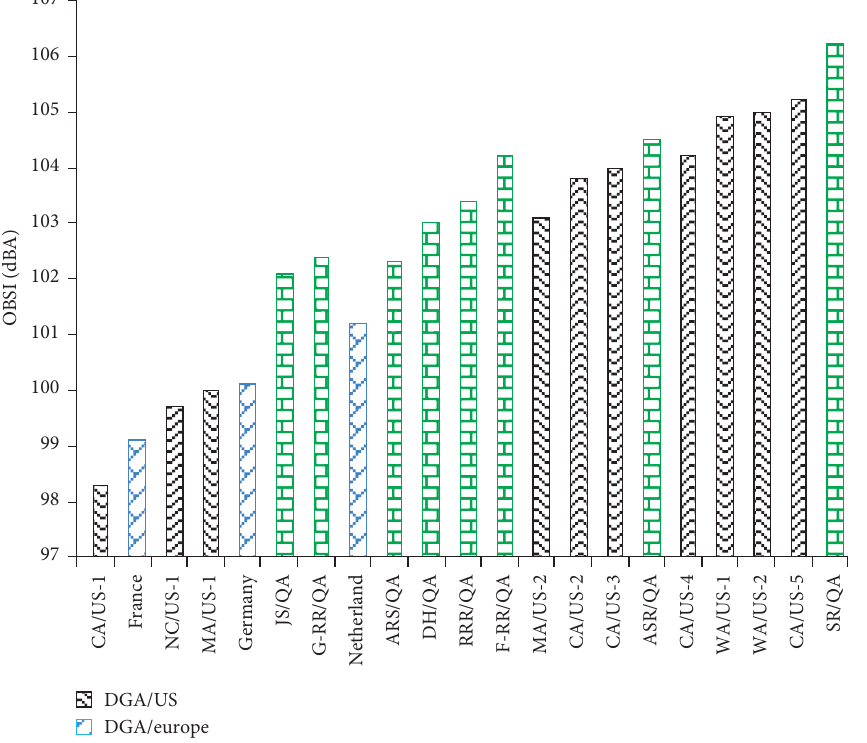
Figure 7: Comparison of normalized noise intensity levels for DGA pavements in Qatar, Europe, and the